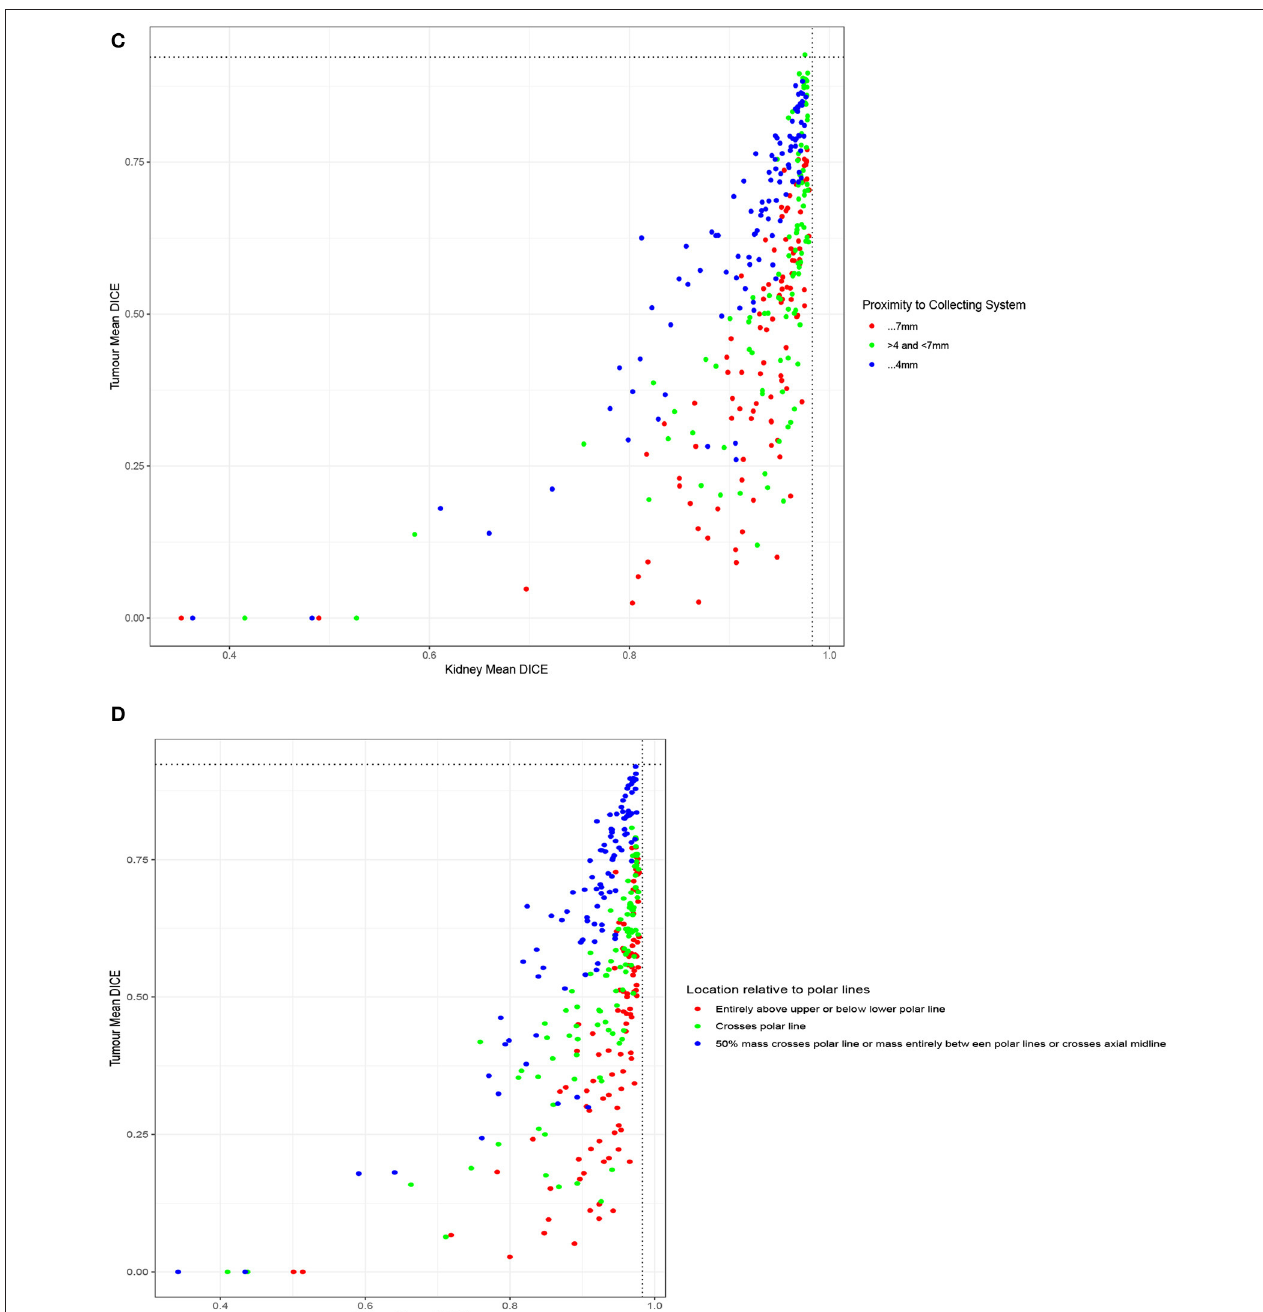
FIGURE 3 | Performance of participating teams based on each component of the RENAL score: (A) tumor diameter, (B) the proportion of the mass, which is endophytic, (C) proximity to collecting system, and (D) location relative to polar